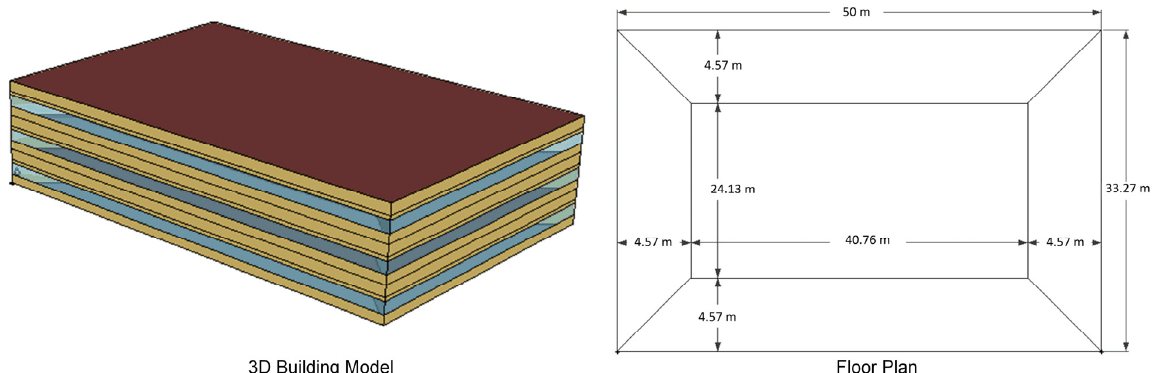
Figure 7. Reference building model and floor